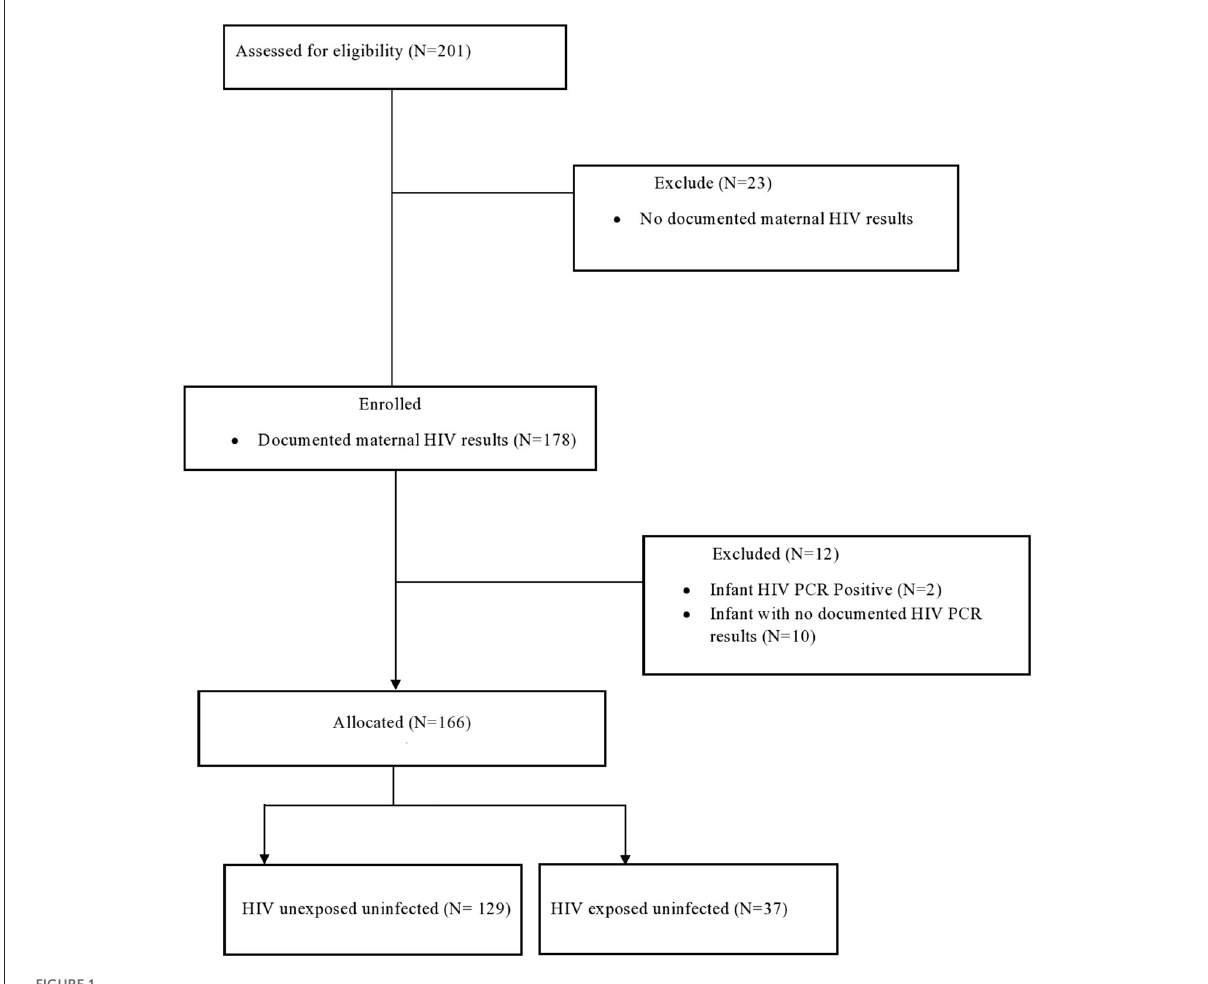
FIGURE1 Flow diagram of neonates included in the